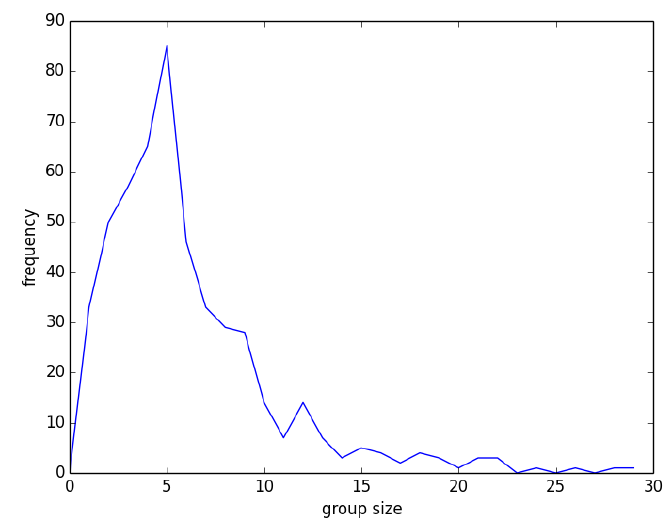
Figure 6. Group size distribution for an instance of a network of 500 nodes having an average degree equals to 6.